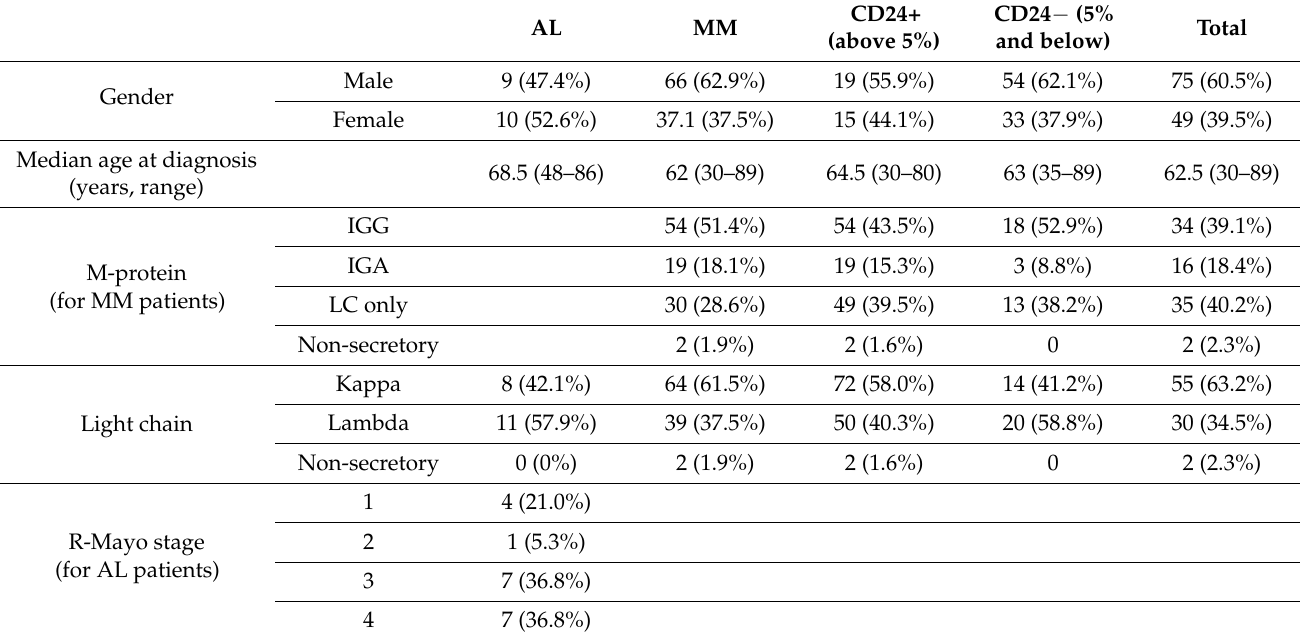
Table 1. Patient baseline characteristics at diagnosis for the main cohort.